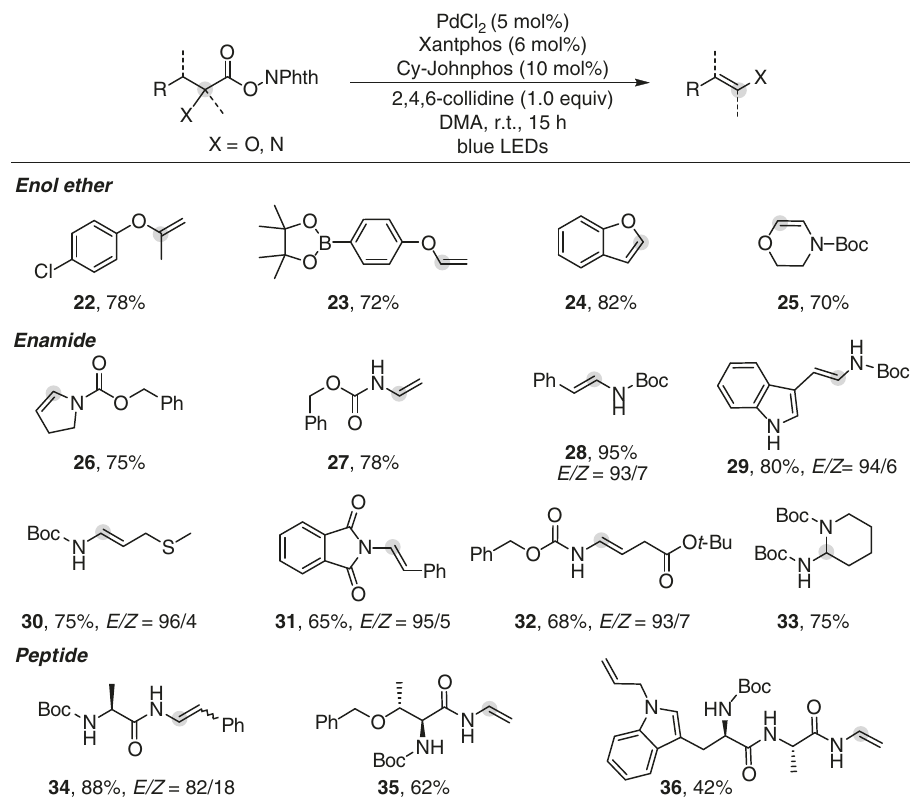
Fig. 3 Scope of the reaction with respect to α -hydroxy and α -amino carboxylates. Reaction conditions: redox-active esters (0.2 mmol), PdCl 2 (5 mol%), Xantphos (6 mol%), Cy-JohnPhos (10 mol%), and 2,4,6-collidine (1.0 equiv) in DMA (2 mL), irradiated with 30 W blue LEDs for 15 h under Ar. Yields of